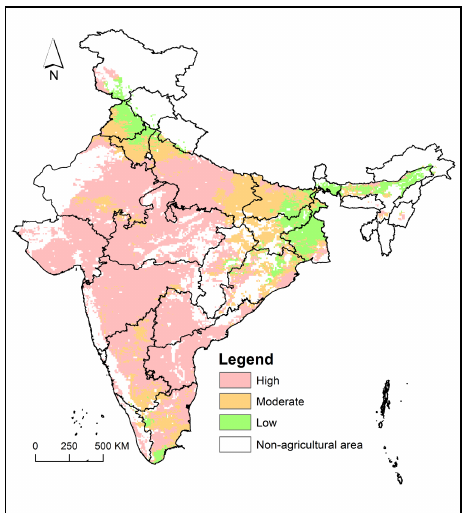
Figure 18 Vulnerability Map of Agricultural Drought During 1982-